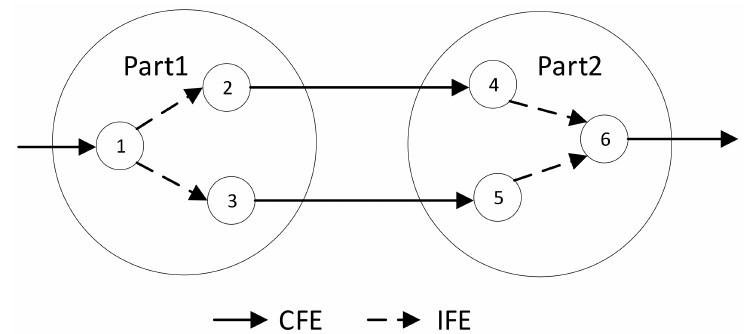
Figure 5. Assembly connection relationship